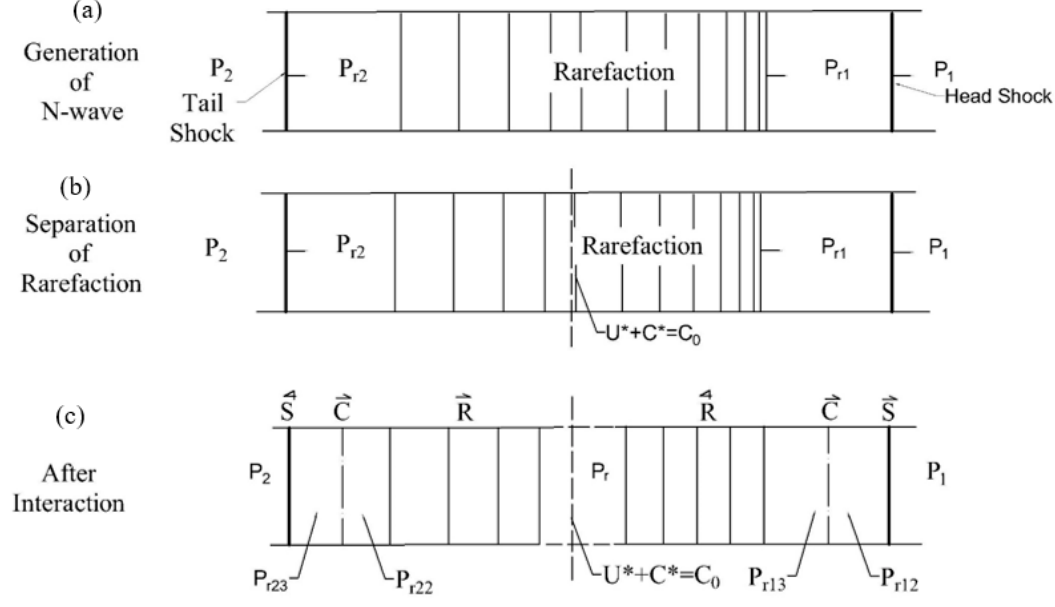
Figure 9. Initial and final conditions of N-wave.